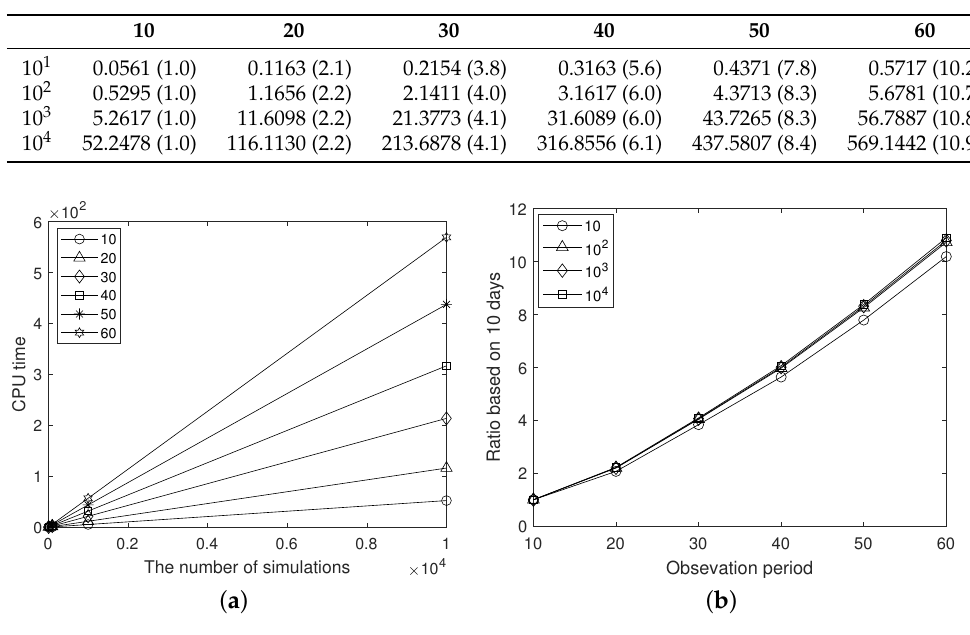
Figure 7. ( a ) Measured CPU time for the observation periods 10,20, · · · ,60 and ( b ) for the number of simulations 10,10 2 , · · · ,10 4 , the ratio of CPU time based on a 10-day observation period. Next, if U C = 1000 and w = 1, then a = 480 and a = 110 for the simple and complex cases, respectively, as shown in Figure 5a,b, respectively. Refer to Figure 8 for a detailed reward at each